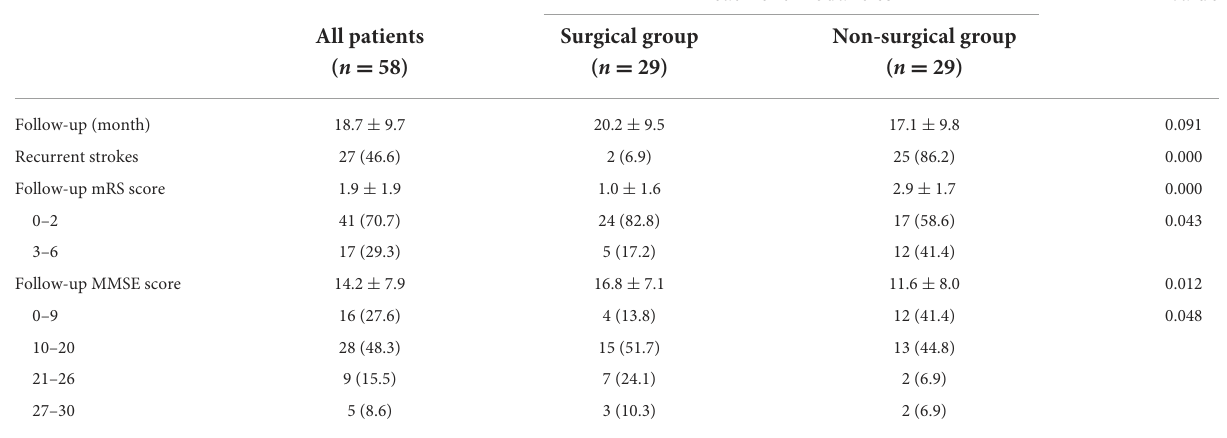
TABLE 5 Neurological status and cognitive function during follow-up in all patients after propensity-score matching. Treatment modalities P -value All patients Surgical